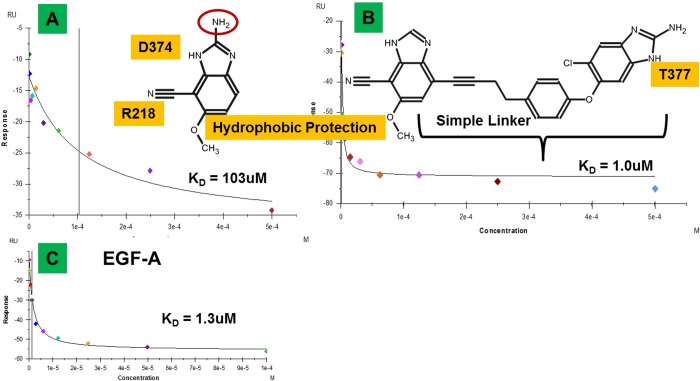
Surface plasmon resonance assay.The cyano-benzimidazole derivative (A) disrupts the PCSK9/LDLR PPI in SPR competition assays. There is no precedent, to our knowledge, for such a small fragment (MW ~ 200) breaking the PPI of a tertiary interface. The amine function circled in red is not relevant for the binding but was left on due to synthetic ease and because SACP indicates that there is free space in this location. The methoxy-ether group was added as hydrophobic protection for the polar interaction at R218 with the cyano group. A simple linker designed to not clash with PCSK9 was added to present the benzimidazole proton at T377 backbone to form the second interaction, resulting in a compound (B) that breaks the PPI with the same potency as the EGFa (C) protein domain of LDLR.